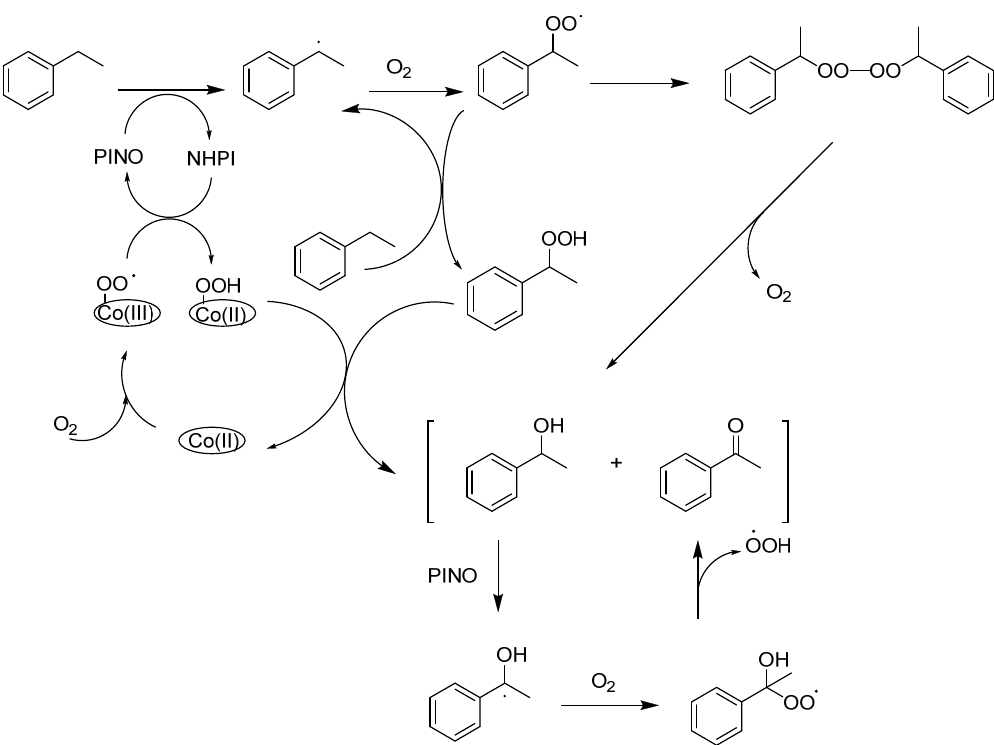
Figure 30. Proposed mechanism for ethylbenzene oxidation catalyzed by Co(II)Pc(SO 3 − ) 4 @-Zn 2 Al-LDH in the presence of O 2 /NHPI (adapted from [79]).